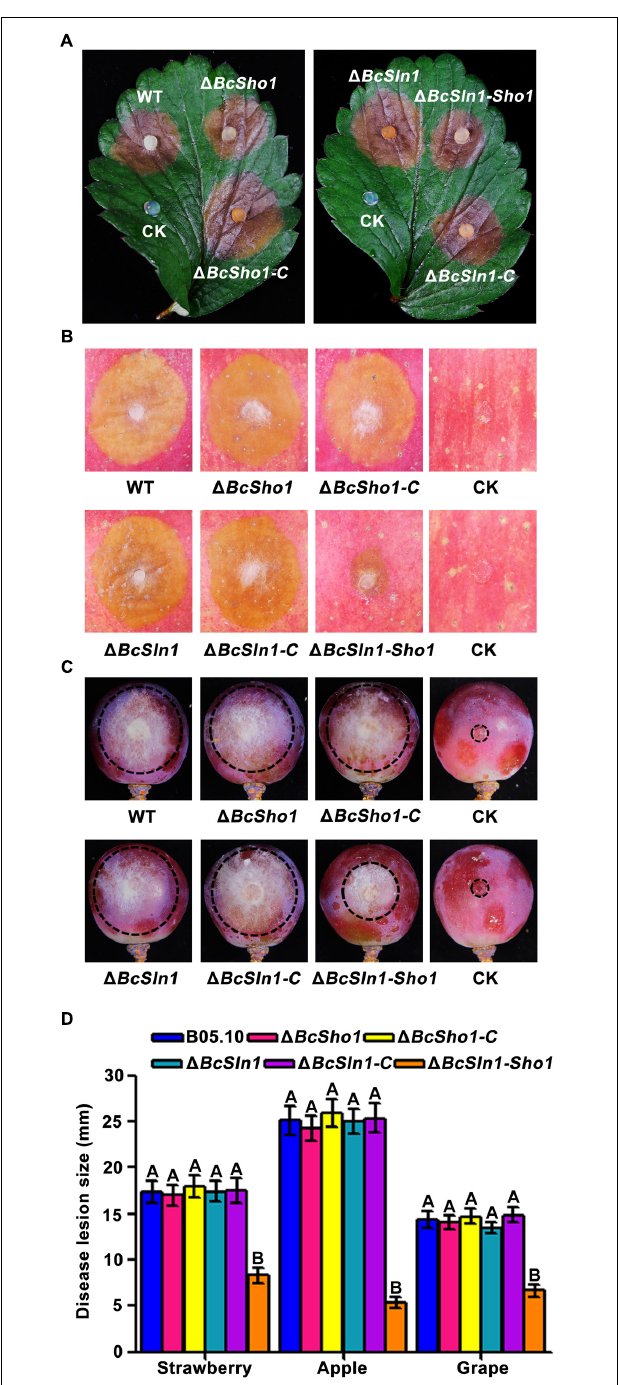
FIGURE 5 | Roles of BcSHO1 and BcSLN1 in virulence. Infection tests on different plant tissues following incubation with B05.10, (cid:49) BcSho1 , (cid:49) BcSln1 , (cid:49) BcSln1-Sho1 , (cid:49) BcSho1-C , and (cid:49) BcSln1-C . Agar plugs without fungal mycelia were used as negative controls (CK). (A) Disease symptom on strawberry leaves at 3 days post-incubation (d.p.i.). (B) Disease symptom on apple fruits at 4 d.p.i. (C) Disease symptom on grape fruits at 4 d.p.i. (D) The diameter of disease lesions caused by each strain. Bars represent standard errors from three replications. Values on the bars followed by the same letter are not significantly different at P =